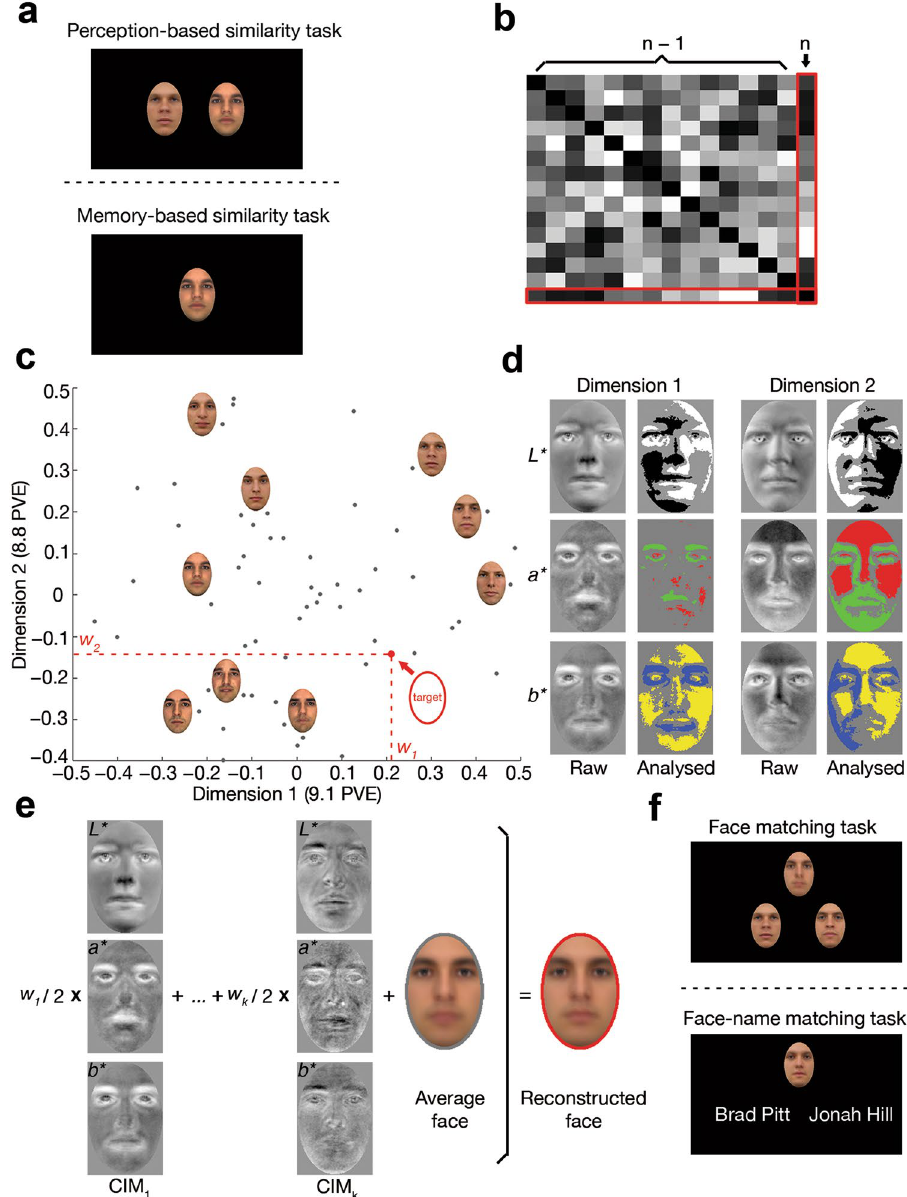
Figure 1. Reconstruction procedure and result evaluation: ( a ) participants rate the face similarity of two stimuli or of a single stimulus against a facial identity retrieved from memory; ( b ) pairwise face similarities are converted into a confusability matrix of n distinct facial identities, where face n is the target face for reconstruction purposes; ( c ) face space is estimated from the similarity of n-1 different faces and the coordinates of the target face are approximated within that space (only 2 dimensions are displayed for convenience; PVE – percent variance explained); ( d ) visual features corresponding to each dimension are derived through image classification from n-1 faces and analysed, separately for each colour channel in CIEL * a * b * , with a pixelwise permutation test (FDR-corrected across pixels; q < 0.10); ( e ) visual features are linearly combined to estimate the visual appearance of the target face (CIM k – classification images corresponding to dimension k ); ( f ) face reconstructions are evaluated in a two-alternative forced choice task with face pairs, for novel faces, or with name pairs, for famous faces. As an illustration, ( c ) and ( d ) show intermediary reconstruction results for participant NC. (Due to copyright restrictions all images of original face stimuli have been replaced with face images artificially generated in Matlab